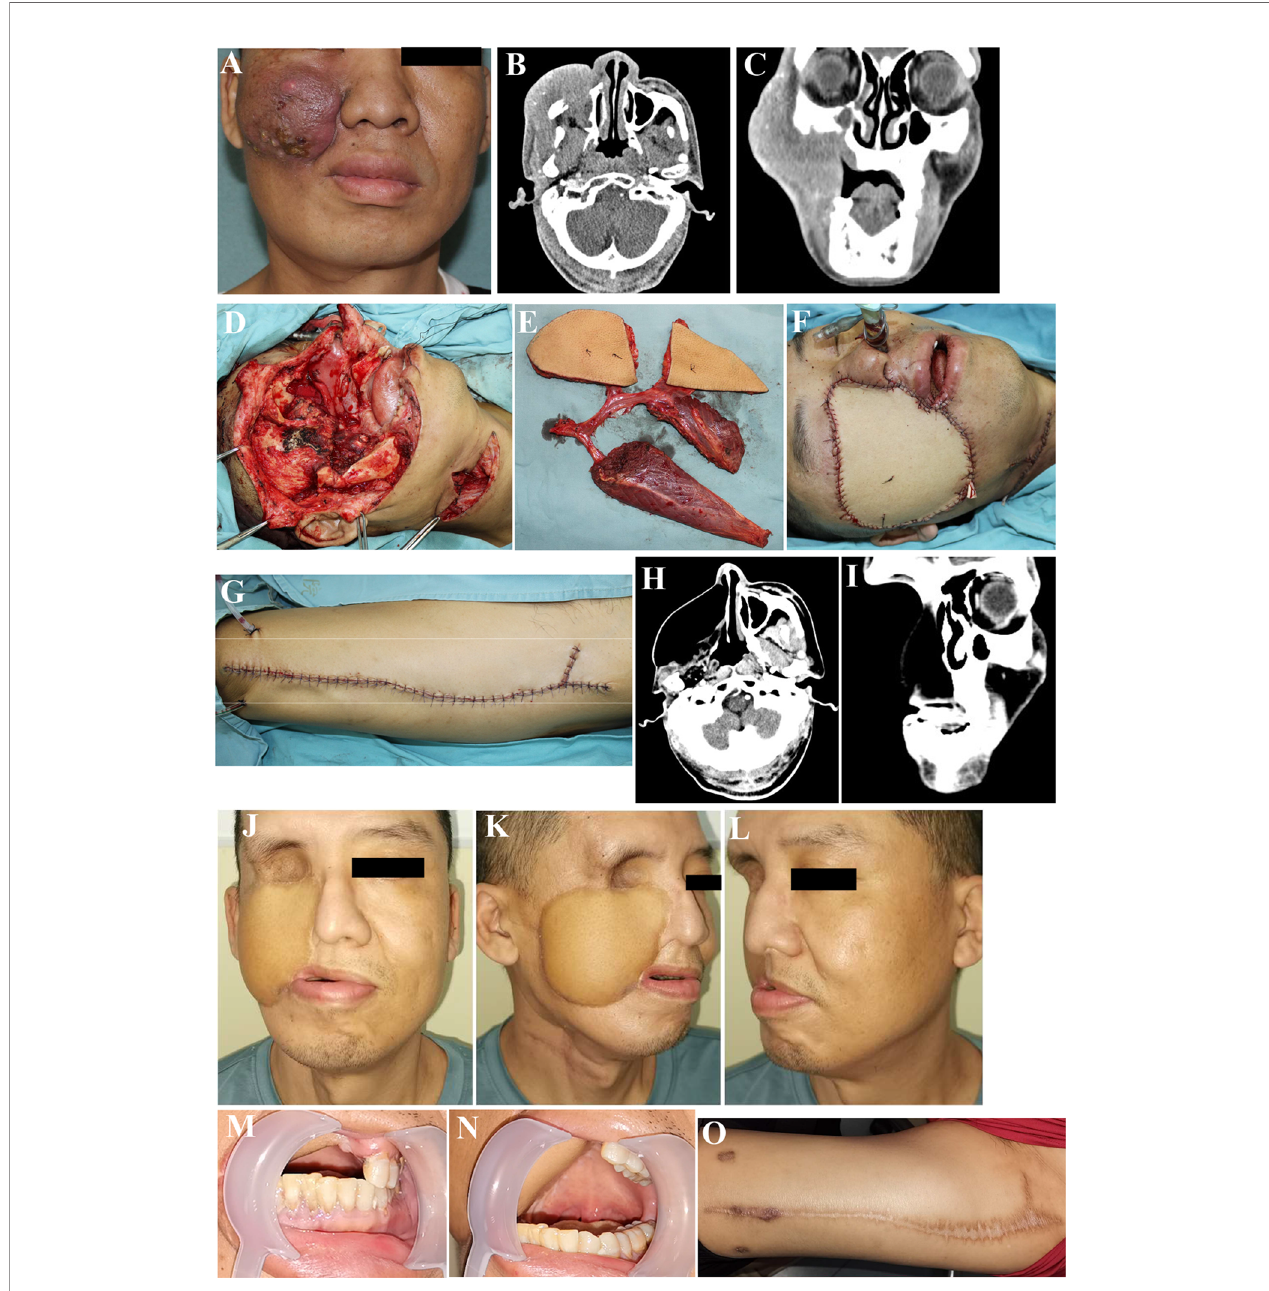
FIGURE 2 | Reconstruction of complex lateral skull base defects using ALT chimeric fl aps. (A) Recurrence of maxillary gingival squamous cell carcinoma, postoperatively after radiation therapy. (B, C) Preoperative CT. (D) Through-and-through cheek and lateral skull base defects after tumor resection. (E) Chimeric ALT, ALT, and rectus femoris fl aps (entire rectus femoris). (F) Defects reconstruction using ALT chimeric fl aps, separate fl aps for intraoral mucosal and extraoral skin reconstruction, and rectus femoris fl ap for lateral skull base dead space fi lling. (G) Primary closure of the donor site. (H, I) Postoperative CT, 52